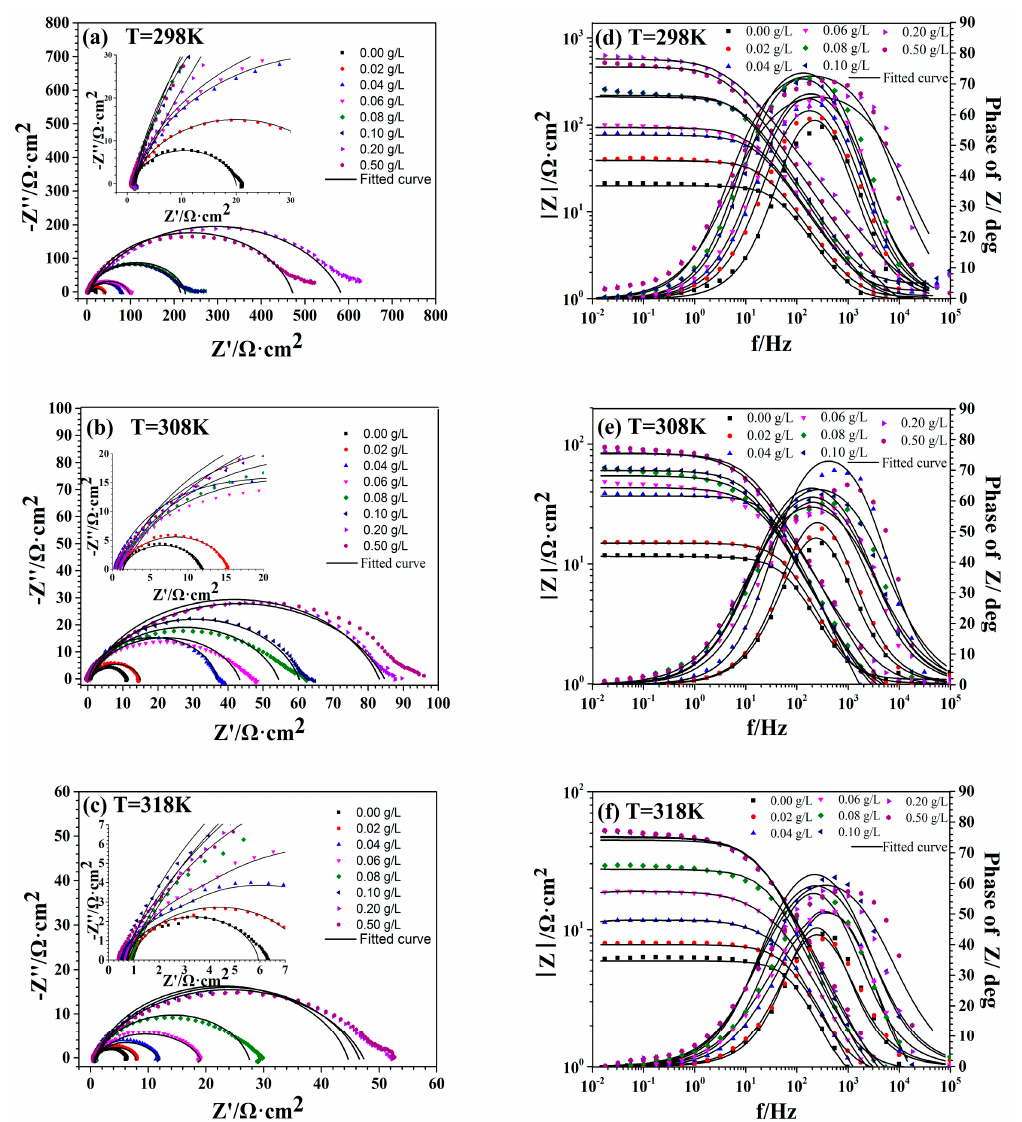
Figure 4. Nyquist plots ( a ) and Bode plots ( b ) of C-steel in 1 M HCl solution with different concentrations of EJTLE at 298 K; Nyquist plots ( c ) and Bode plots ( d ) of C-steel in 1 M HCl solution with different concentrations of EJTLE at 308 K; Nyquist plots ( e ) and Bode plots ( f ) of C-steel in 1 M HCl solution with different concentrations of EJTLE at 318 K.